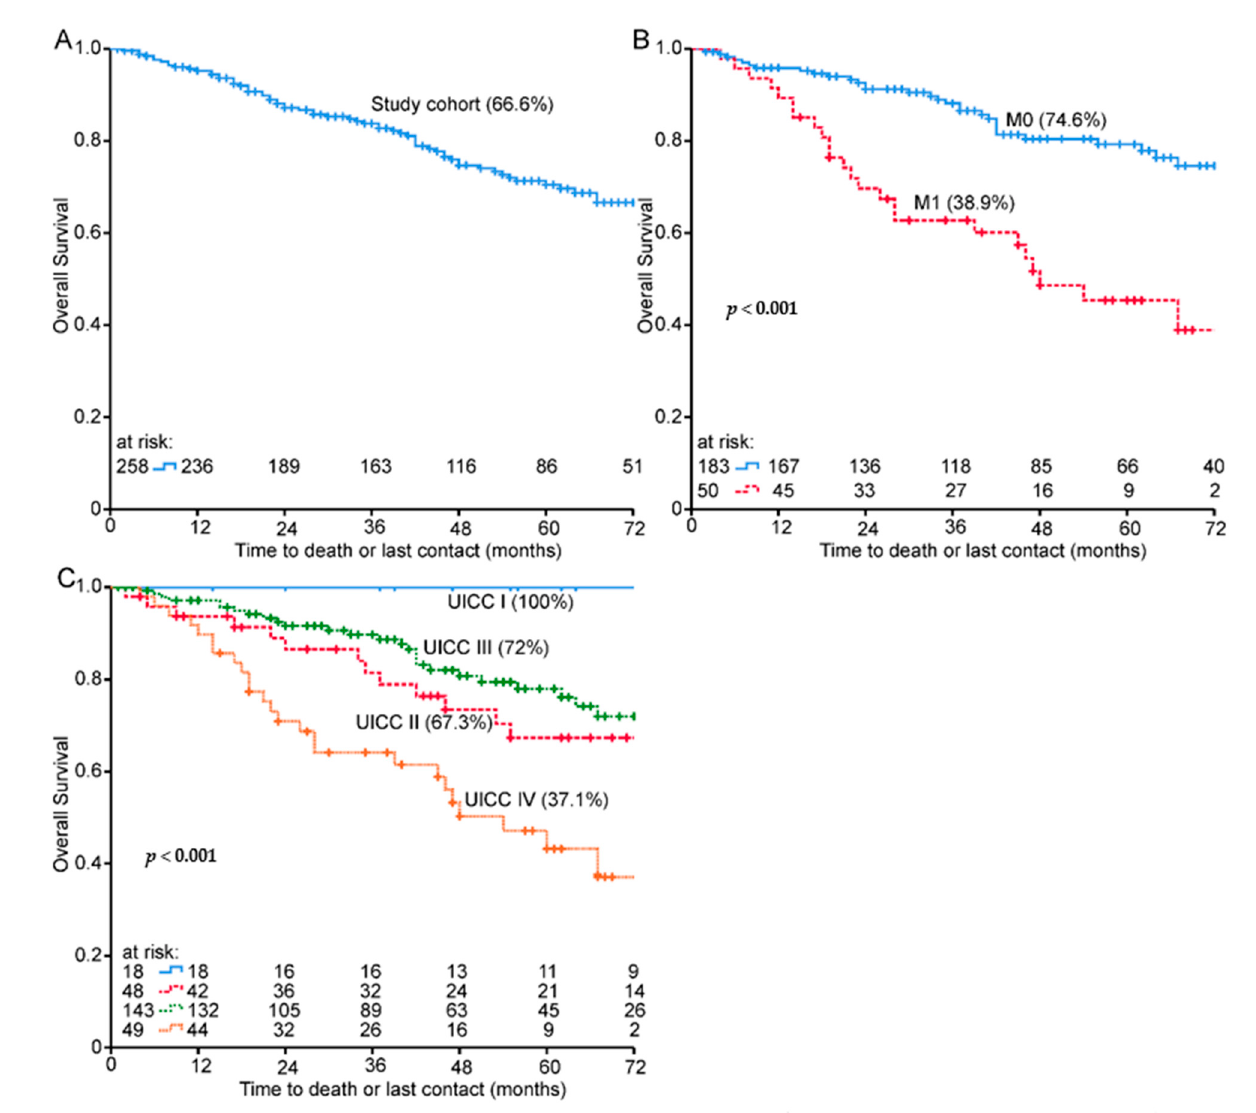
Figure 1. Kaplan–Meier plots for ( A ) overall survival of the entire cohort, ( B ) TNM: distant metastasis M and ( C ) stage UICC I–IV. Seventy-two-month overall survival % in brackets.